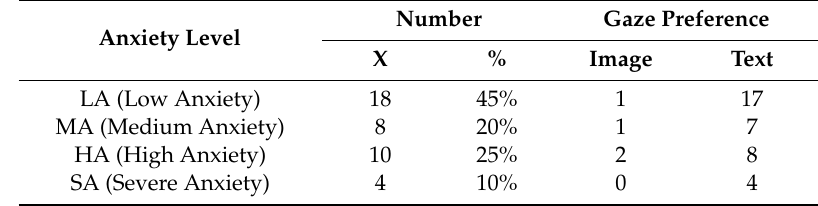
Table 8. Categorization by anxiety level.